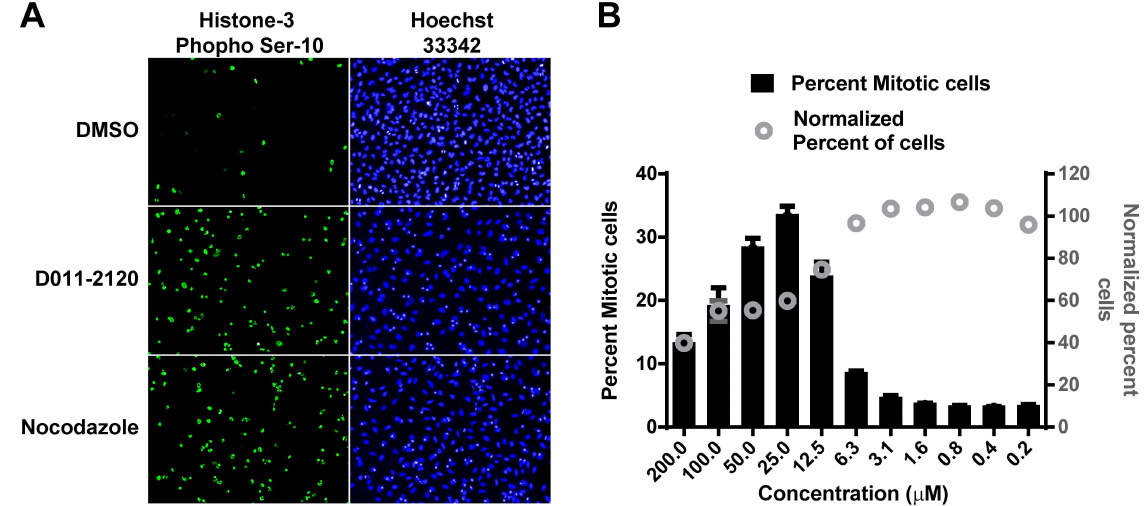
Figure 8. D011-2120 induces mitotic arrest. ( A ) Representative images of HeLa cells treated with vehicle control (0.5% DMSO), D011-2120 (50 m M), or nocodazole (33 m M) for 24 h and immunostained with Histone 3 phospho Serine 10 (pH3-S10) antibody to detect mitotic cells (green). Nuclei are stained with Hoechst 33342 (blue). ( B ) Graph of data acquired using HCI-based analysis showing the percent mitotic cells treated with increasing concentrations of D011-2120 as indicated on the X-axis.